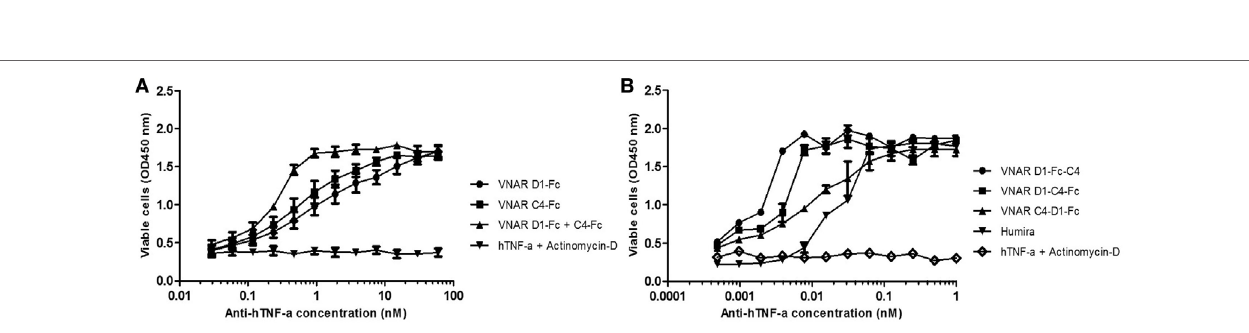
FigUre 5 | hTNF- α neutralizing capacity of the Fc-based variable new antigen receptor (VNAR) constructs. (a) VNAR-Fc constructs demonstrating high neutralization potencies. D1–Fc + C4–Fc denotes equimolar dosing of both constructs. Results shown are the mean ± SEM ( n = 3) with two replicates per experiment. (B) A demonstration of the superior potency of the Quad ™ VNAR constructs over Humira ® in neutralizing hTNF- α -induced cytotoxicity in L929 cells. Results shown are the mean ± SEM ( n = 4) with two replicates per experiment (D1–Fc–C4) and mean ± SD ( n = 2) with two replicates per experiment for the other constructs and Humira ® .